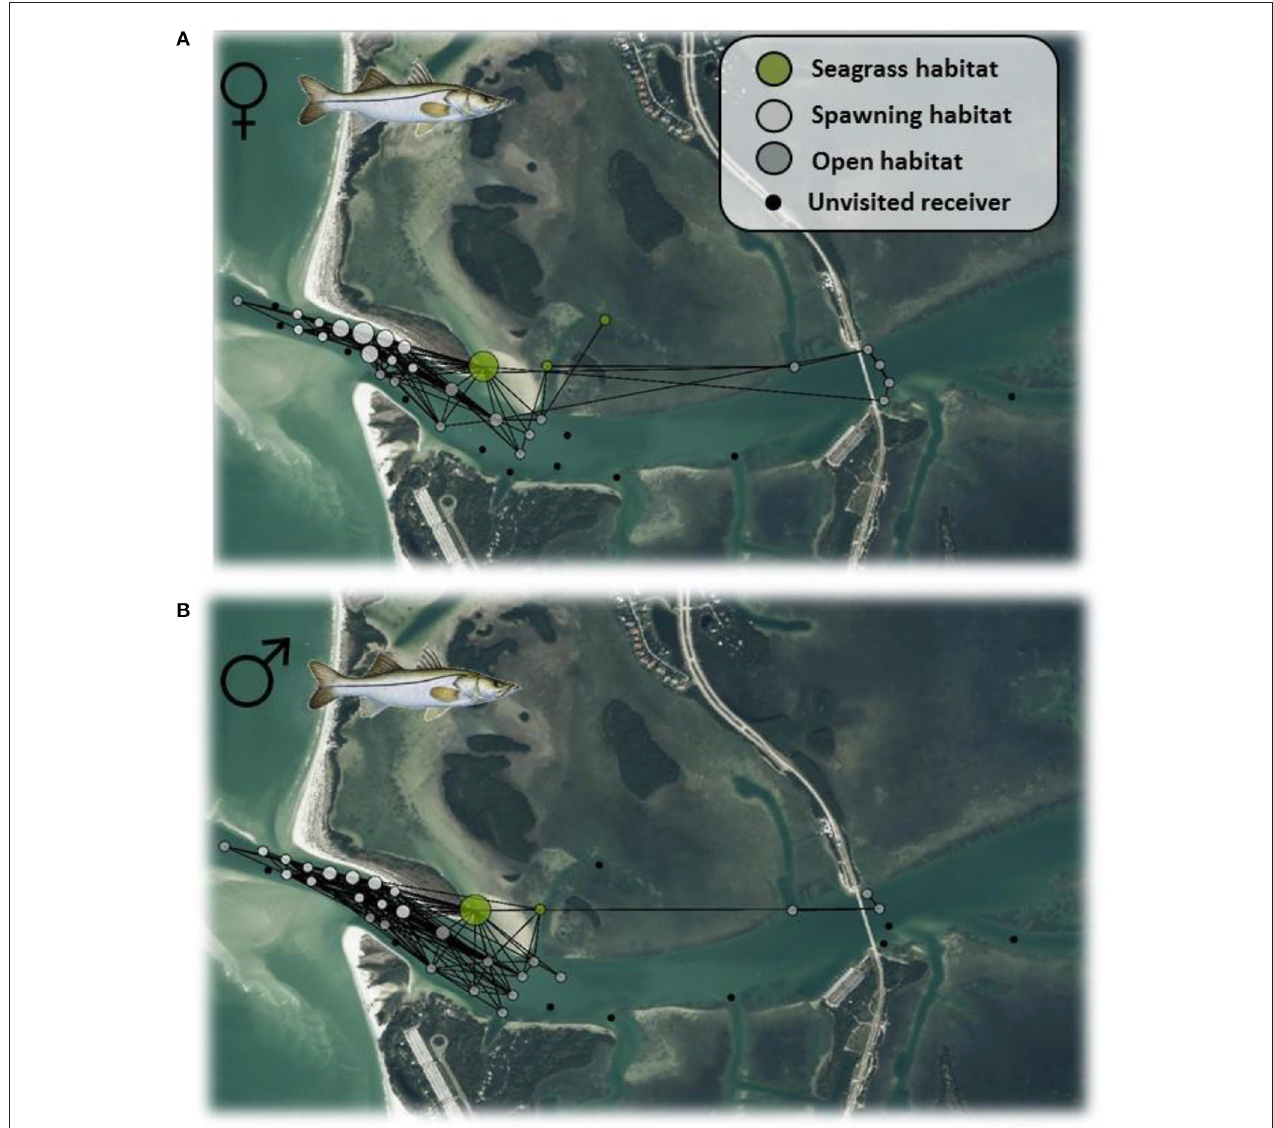
FIGURE 2 | Weighted network for female (A) and male (B) Snook in Tampa Bay according to the spatial layout of acoustic receivers. Node coloration corresponds to different habitats, while node size corresponds to the degree centrality, a measure of node connectedness. Green shading represent the seagrass habitat, and light gray shading represent the spawning habitat, dark gray shading shows open habitats, and black dots show unused